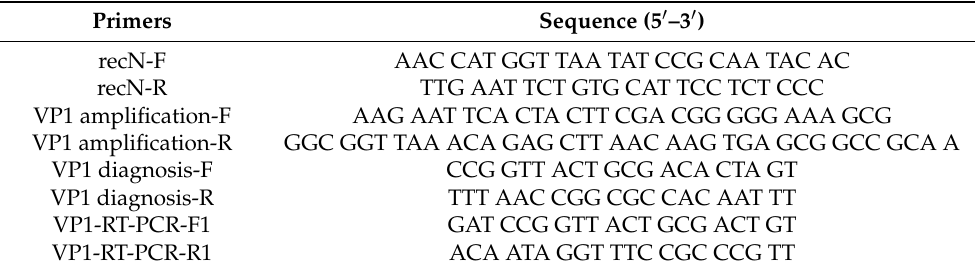
Table 2. Primers used in this